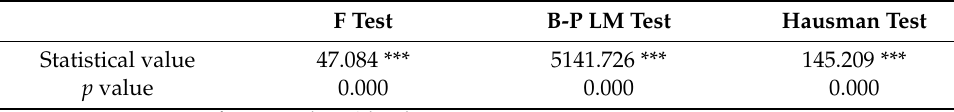
Table 2. Discriminant tests for panel data models. F Test B-P LM Test